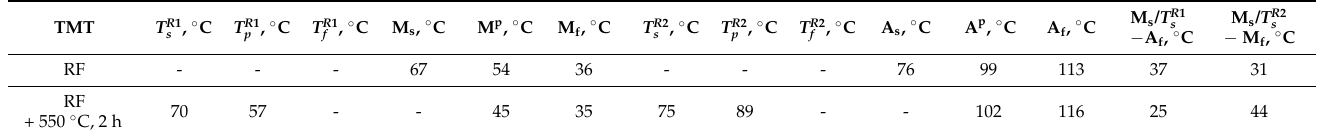
Table 5. Characteristic temperatures of forward and reverse MTs of TiNiHf rods after RF and RF + PDA at 550 °C for 2h.